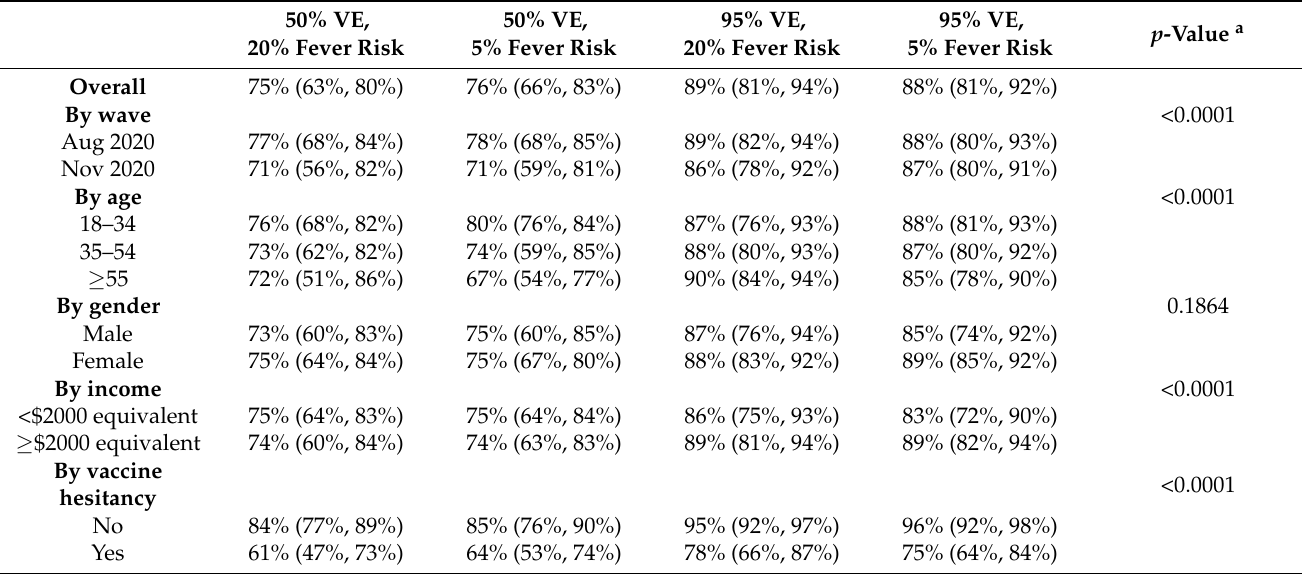
Table 4. Marginal estimates of vaccine acceptance (and 95% confidence intervals) across different vaccine profiles as predicted by logistic regression models, stratified by demographic characteristics in six